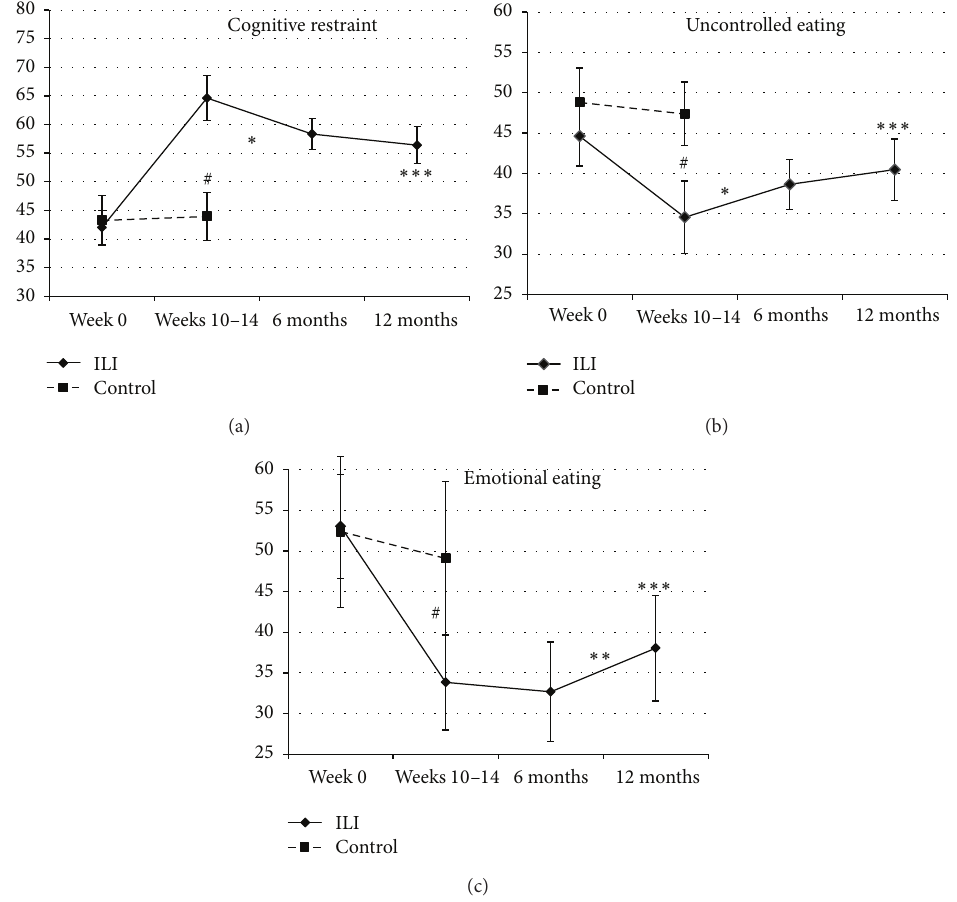
Figure 6: Mean (95% CI) scores of eating behavior (TFEQ-21) at week 0, weeks 10–14, six, and 12 months followup. # 𝑃 < 0.007 for differences in changes between ILI-group and controls, ∗ 𝑃 < 0.02 for changes within the ILI-group from weeks 10–14 to six months, ∗∗ 𝑃 = 0.012 for changes within the ILI-group from six to 12 months, and ∗∗∗ 𝑃 < 0.04 for changes within the ILI-group from week 0 to 12 months. Table 6: Change in exercise capacity within the ILI-group. Data are mean values (SD or 95% CI).